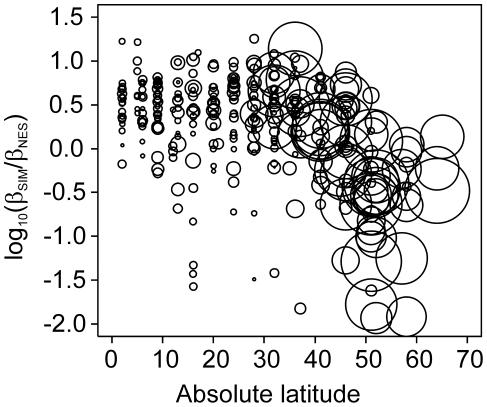
World latitudinal variation (latitude in absolute values) in the ratio between intra-regional turnover (βSIM) and nestedness (βNES) (logarithmic scale).The sizes of the circles are proportional to the difference in temperature between the present and LGM scenarios. Note the change in both the sizes of the circles and the preponderance of nestedness patterns between 30 and 40 degrees of latitude.